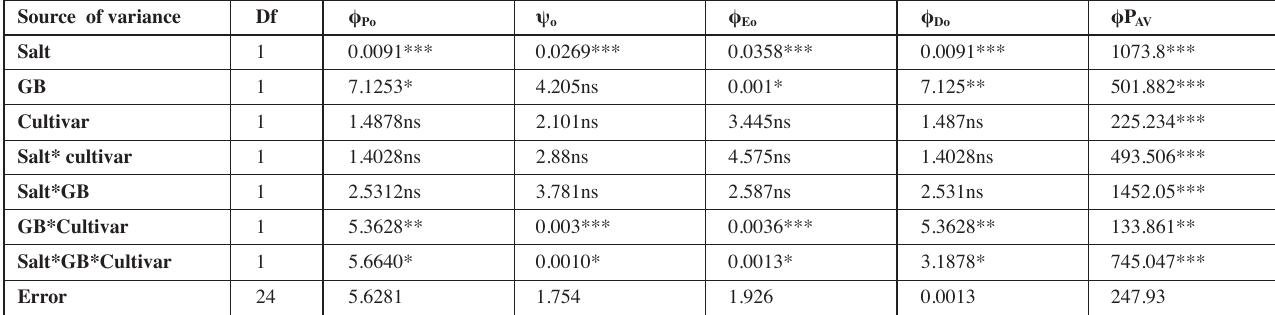
Tab. 3: Mean squares from analysis of variance of data for φ Po, ψ o , φ Eo , φ Do , φP AV in leaves of two cultivars of canola ( Brassica napus L.) treated with or without foliar spray of GB to salt stressed and non stressed condition. Source of variance